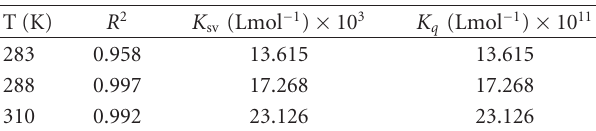
Table 2: The quenching constants of Pt (II) complex by CT DNA at di ff erent temperatures ranging from 0–5 × 10 − 5 mol L − 1 of CT DNA.